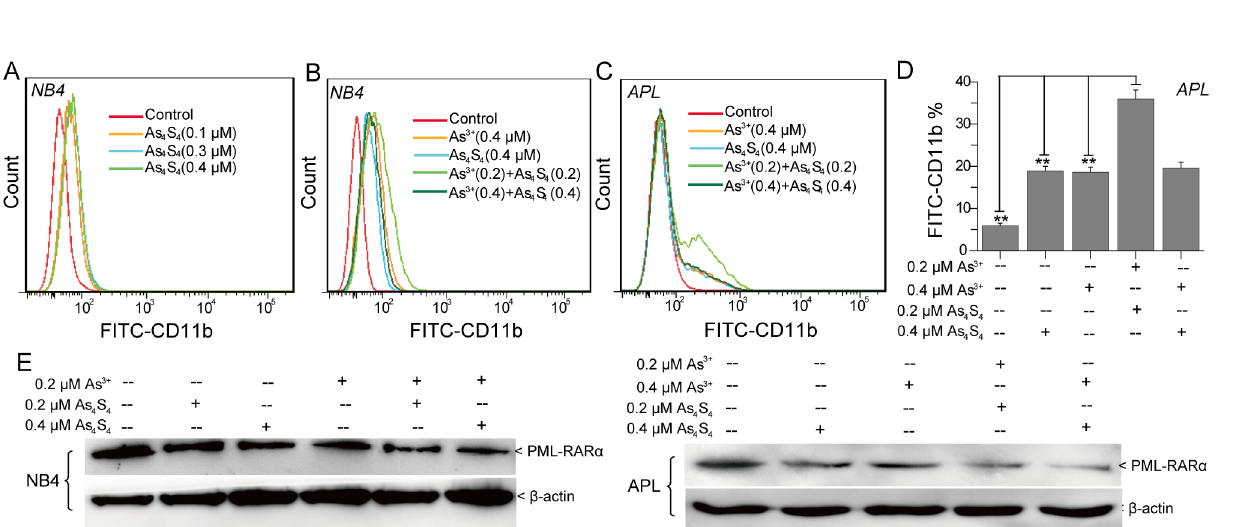
Fig 7. As 4 S 4 acts synergistically with As 3+ to affect NB4 and primary APL cell differentiation. (A) The effects of As 4 S 4 on CD11b expression in NB4 cells. (B) The effects of As 4 S 4 on As 3+ -induced differentiation in NB4 cells. (C) The effects of As 4 S 4 on As 3+ -induced differentiation in primary APL cells. (D) The percentage of FITC-CD11b-positive primary APL cells. (E) Western-blot analysis of PML-RAR α expression in NB4 and primary APL cells. The figures show a representative experiment of three independent experiments. ** P < 0.01 compared with 0.2 μ M As 3+ and 0.2 μ M As 4 S 4 combination treated cells.